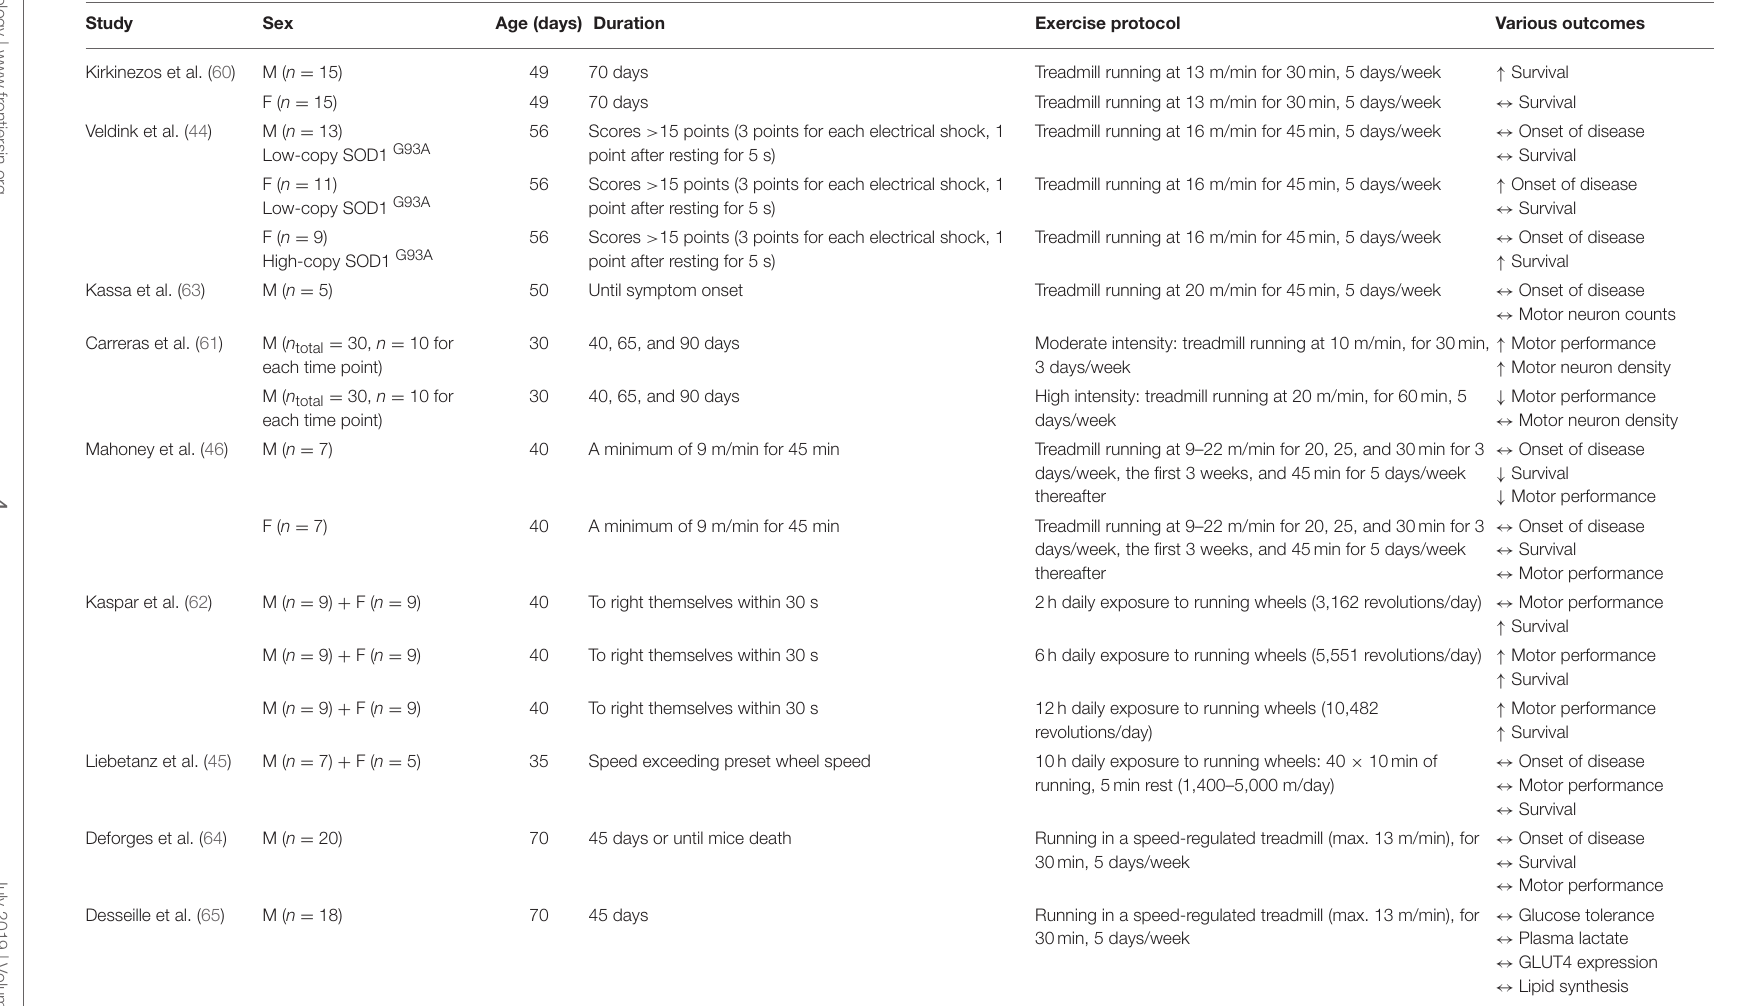
TABLE 1 | Summary of the effects of running-based endurance training in SOD1 G93A ALS mice.